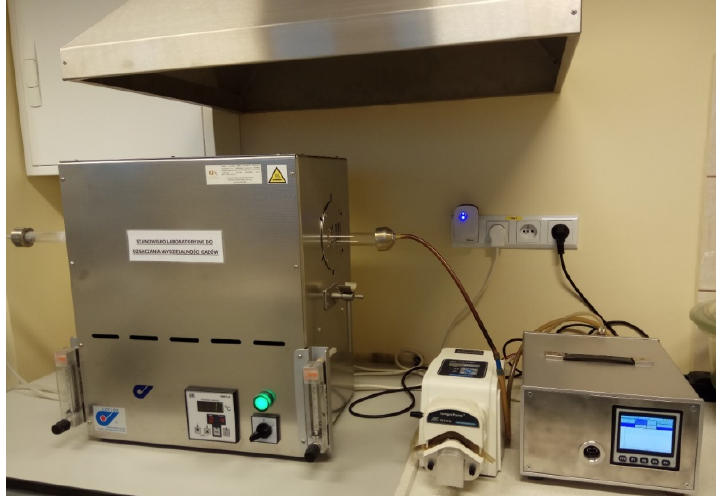
Figure 1. Gas emissivity measuring device.